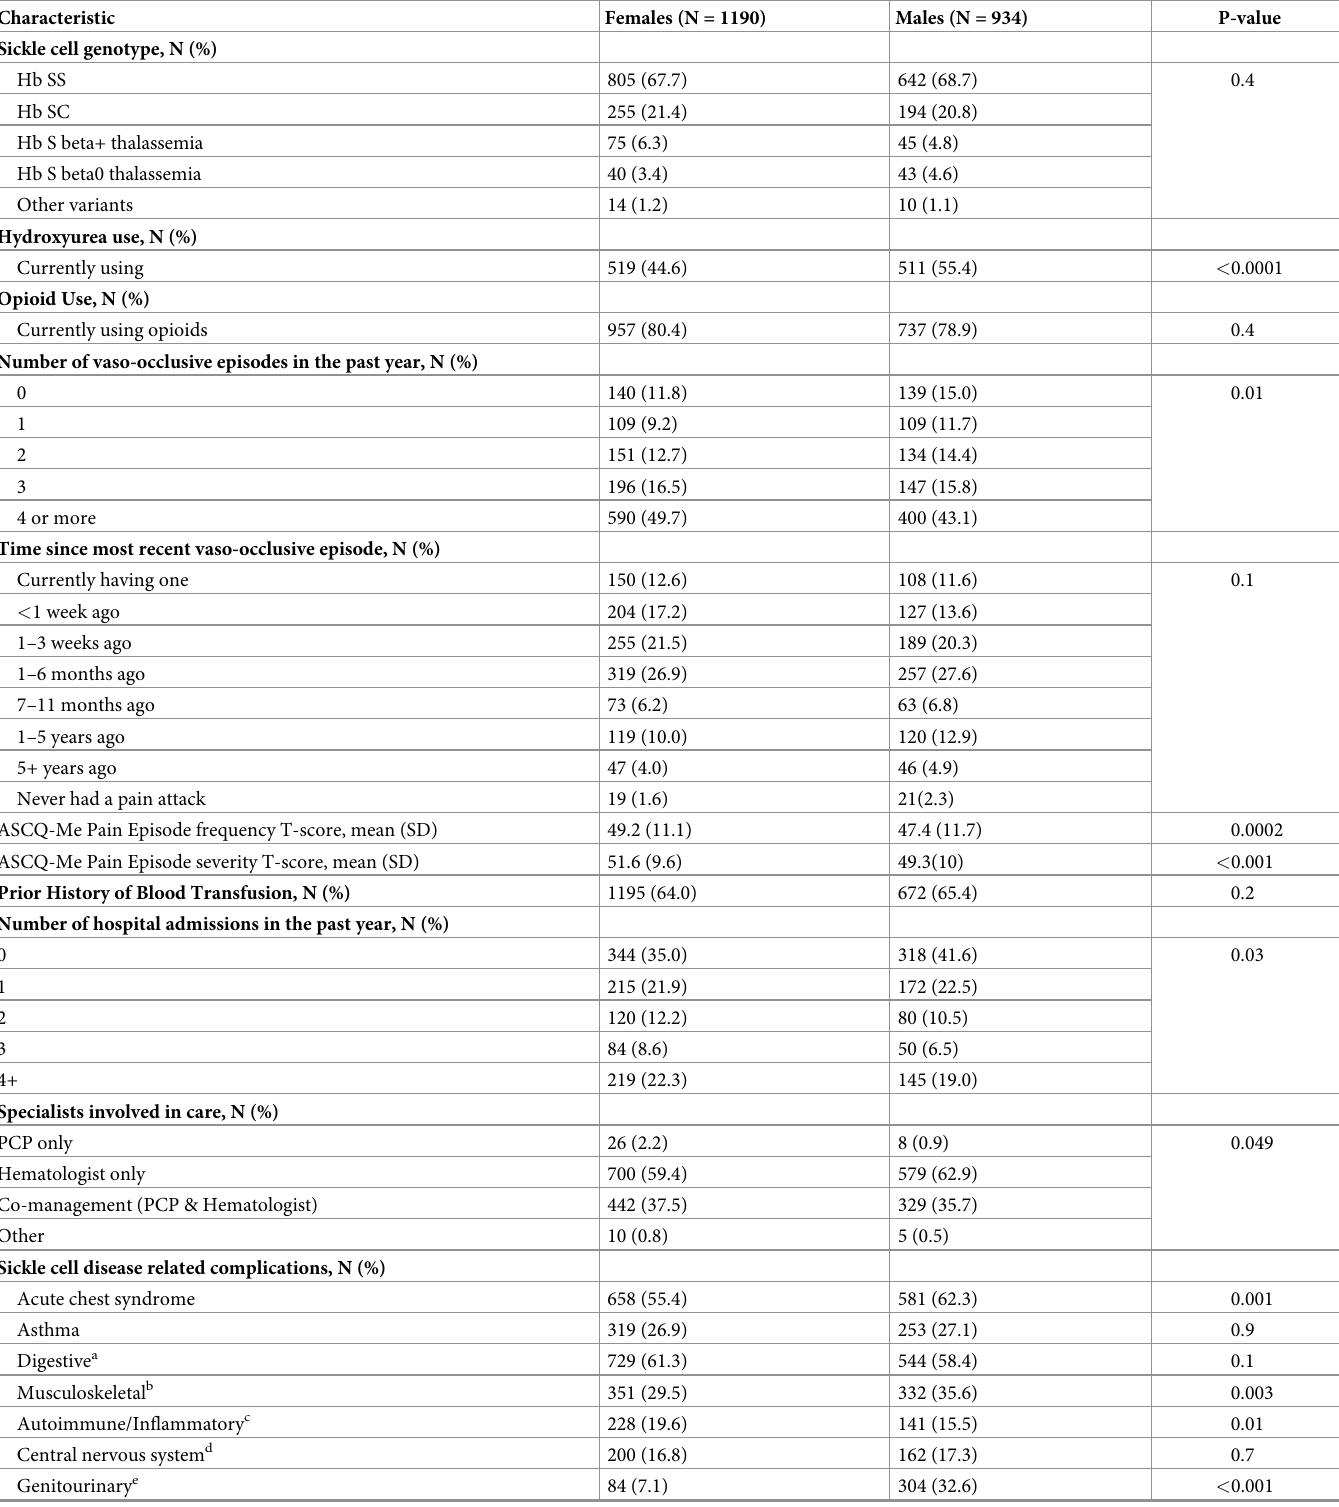
Table 2. Disease